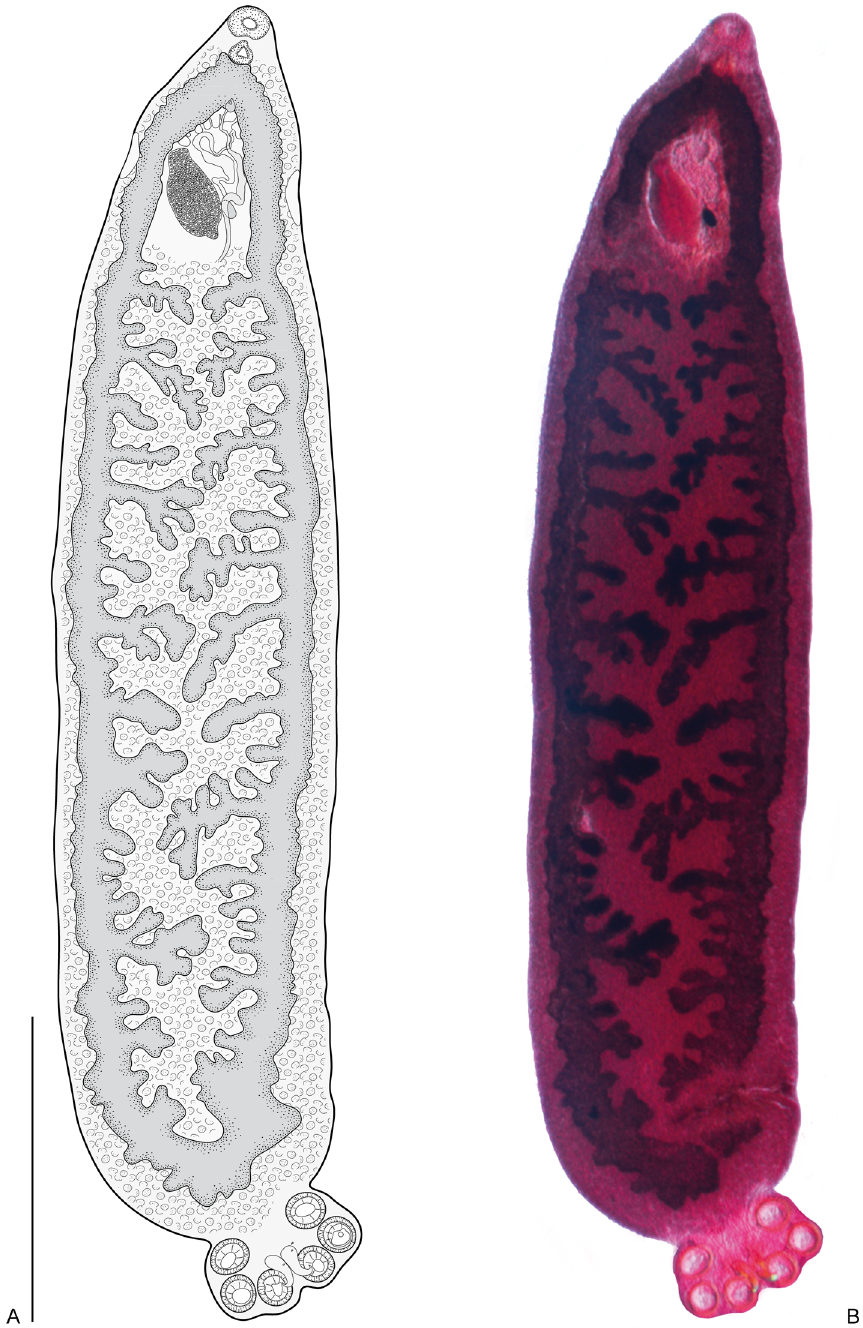
Figure 5. Indopolystoma elongatum n. gen. n. sp. from Zhangixalus arboreus . Ventral view of holotype. (A) A drawing; (B) A photograph. Scale bar: 1